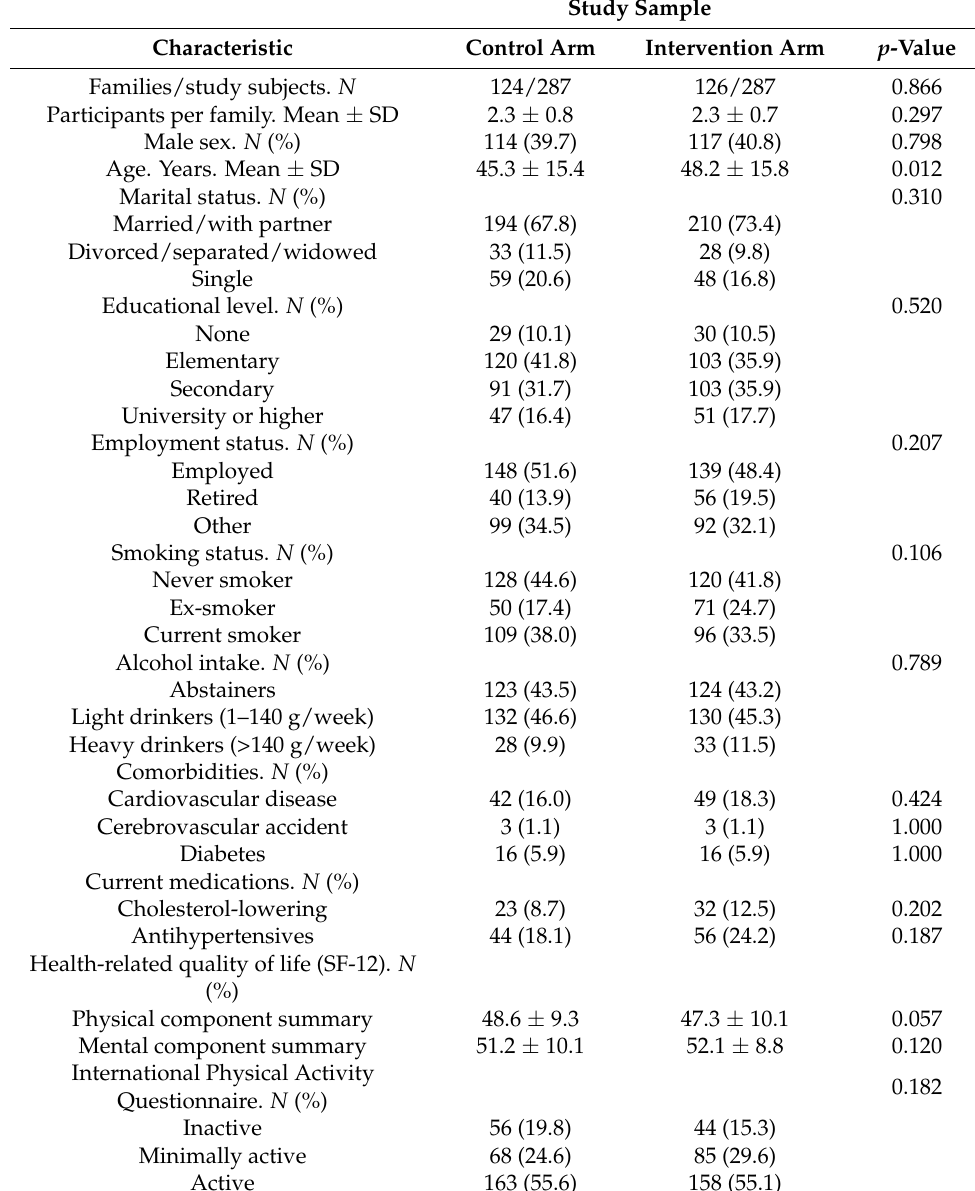
Table 2. Baseline characteristics of the study participants (intention-to-treat data